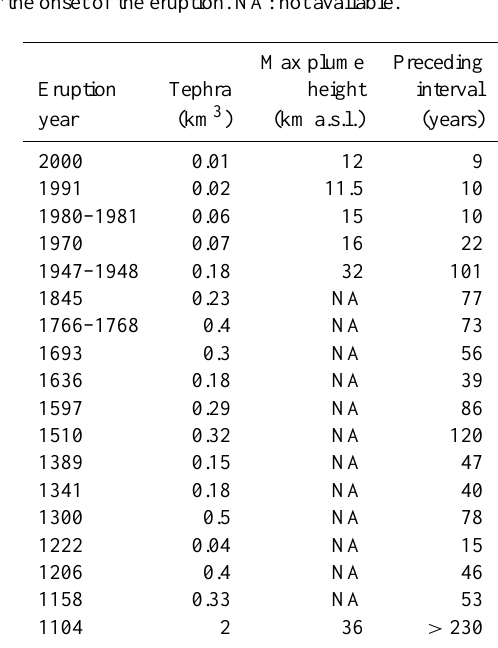
Table 1. Historical eruptions at the central volcano of Hekla (see Thordarson and Larsen, 2007, and references therein). Tephra vol- umes are recorded as “freshly fallen” (i.e. 40% larger than volumes of old eruptions inferred from field mapping; Thorarinsson, 1967). Following the typical pattern of mixed eruptions at Hekla, plume heights correspond to the maximum altitude reached a few minutes after the onset of the eruption. NA: not